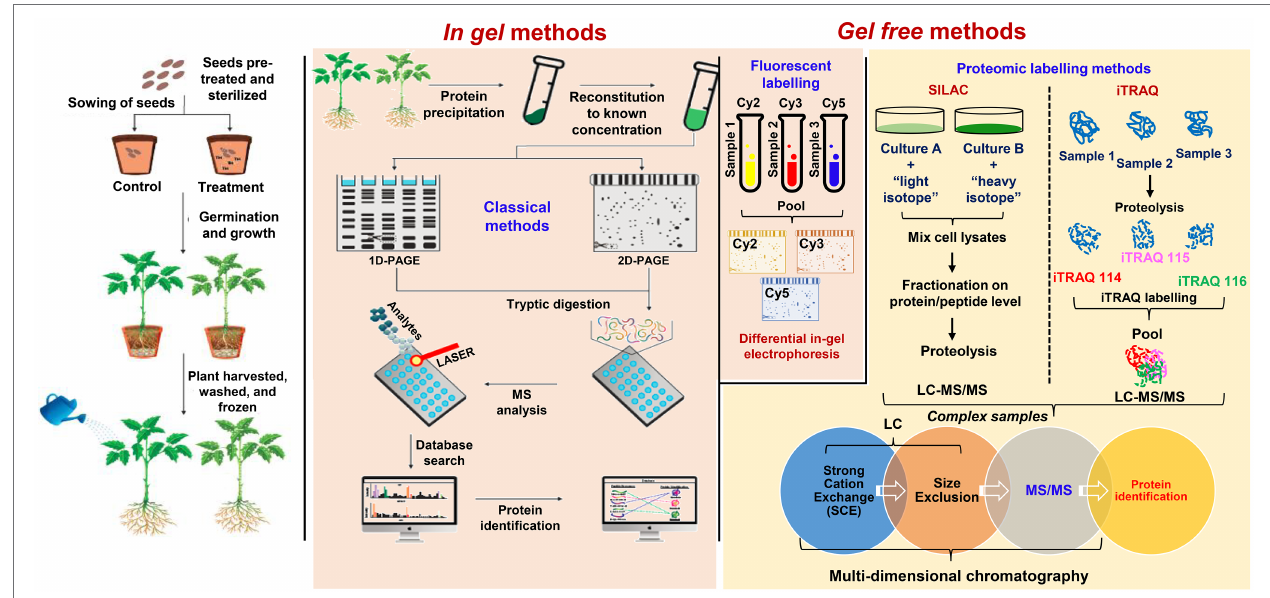
FIGURE 1 | A workflow illustrating the comparative proteomic methods that have been used to investigate the phytoremediation of potentially toxic elements. Classical in-gel proteomic methods include 1-D and 2-D polyacrylamide gel electrophoresis (PAGE) sometimes further developed by differential in-gel electrophoresis (DIGE) using fluorescent tags like cyanine 2 or 3 or 5 (Cy2, Cy3, and Cy5). Gel-free methods are advanced and used to overcome limitations in-gel proteomics and to study the heavy metal detoxification and phytoremediation mechanisms. These include novel gel-free methods with protein labeling such as Stable Isotope Labeling with Amino acids in Cell culture (SILAC) and Isobaric Tags for Relative and Absolute Quantitation (iTRAQ) techniques followed by multi- dimensional chromatography